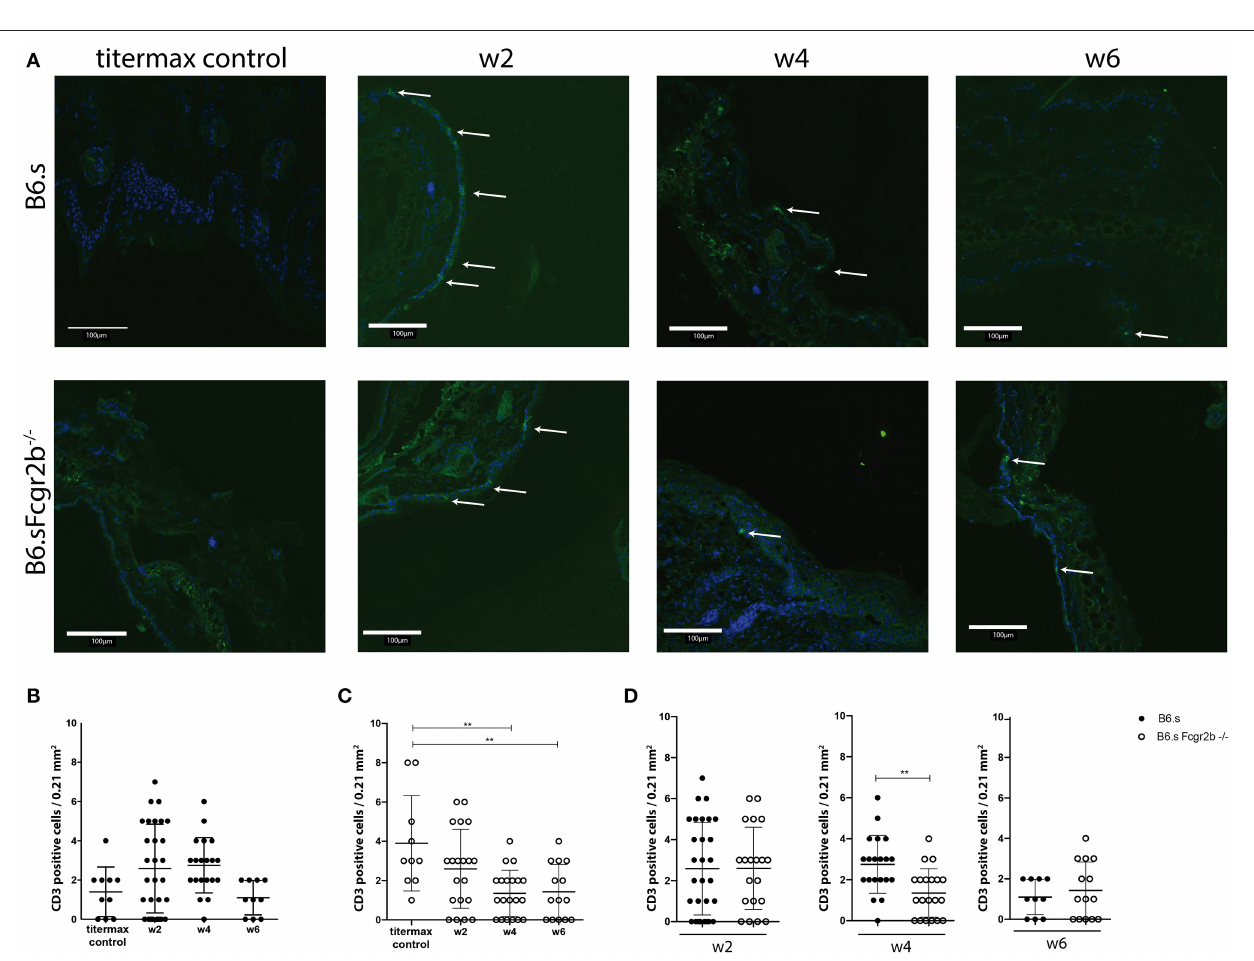
FIGURE 4 | vWAF2 antigen. Red = Ly6G + neutrophils; Blue = DAPI. (B,C) Quantitative evaluation of Ly6G + neutrophils in 0.15 mm 2 sections of B6.s wt (B) and B6.s- Fcgr2b − / − mice (C) during the 6 weeks observation period at week 2, 4, and 6. Titermax Control: representative staining of skin sections from B6.s wt and Fcgr2b − / − mice treated with Titermax (D) . Comparison of the Ly6G + neutrophil numbers in the skin of B6.s and B6.s- Fcgr2b − / − mice at week 2 (left panel), 4 (middle panel), and 6 (right panel). Pictures were analyzed via ImageJ and Celleste software. (E) Presence of MPO + signals in the skin of B6.s wt and B6.s- Fcgr2b − / − mice. Representative immunofluorescence staining of ear sections taken 2, 4, and 6 weeks after immunization with vWAF2 antigen. Green = MPO + signals; Blue = DAPI. (F,G) Quantitative evaluation of MPO + signals in 0.15 mm 2 sections of B6.s wt (G) and B6.s- Fcgr2b − / − mice (G) during the 6 weeks observation period at week 2, 4, and 6. Control: Representative staining of skin sections from B6.s wt and Fcgr2b − / − mice treated with Titermax (D) . Comparison of the MPO + signals numbers in the skin of 6.s and B6.s- Fcgr2b − / − mice at week 2 (left panel), 4 (middle panel), and 6 (right panel). Data in (B–D) and (F–H) are shown as scatter blot with mean ± SEM. Differences between week 2, 4, and 6 in (B,C,F,G) were analyzed by non-parametric one-way ANOVA. Differences between B6.s and B6.s- Fcgr2b − / − mice (D,H) were evaluated by unpaired Student’s t -test (* p < 0.05, ** p < 0.01,**** p < 0.0001).